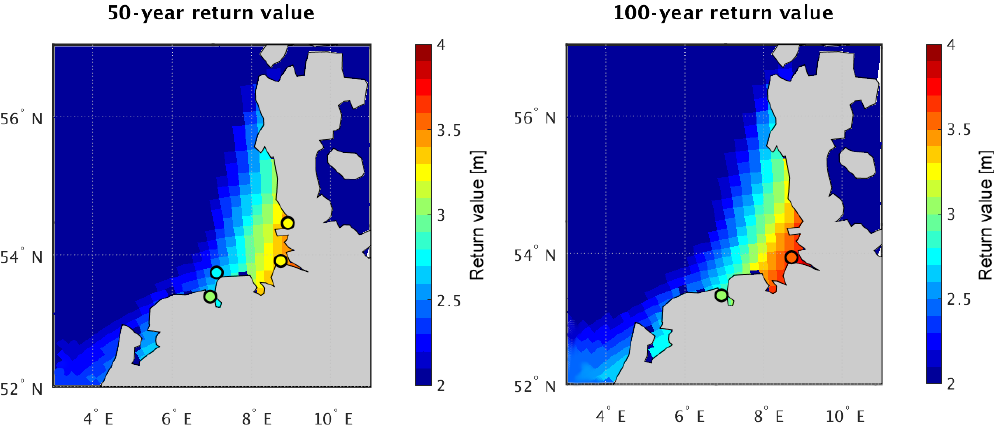
Figure 6. Gridded 50- and 100-year return levels and the corresponding water values from tide gauge observations at selected locations (circles). All values given in meters above mean high